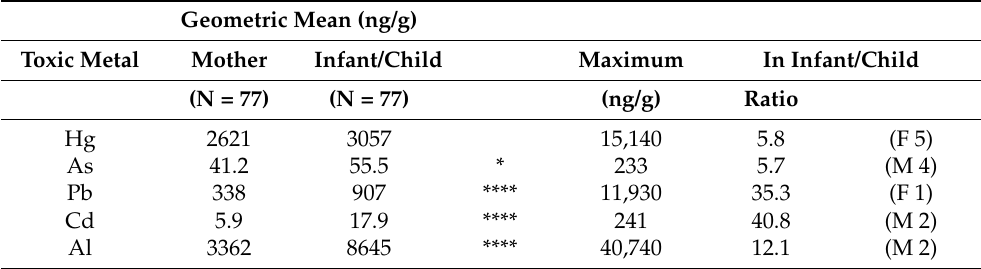
Table 1. Mean toxic metal concentrations in scalp hairs of infant/child and their mothers. Geometric Mean (ng/g) Toxic Metal Mother